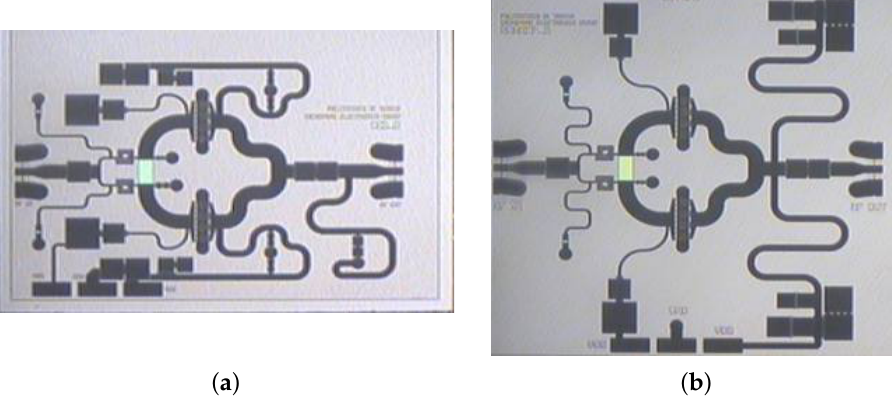
Figure 4. Microscope picture of the Tuned Load (2.8 × 1.9 mm 2 ) ( a ), and Harmonic Tuned (2.8 × 2.8 mm 2 ) ( b ) Microwave Monolithic Integrated Circuit (MMIC)